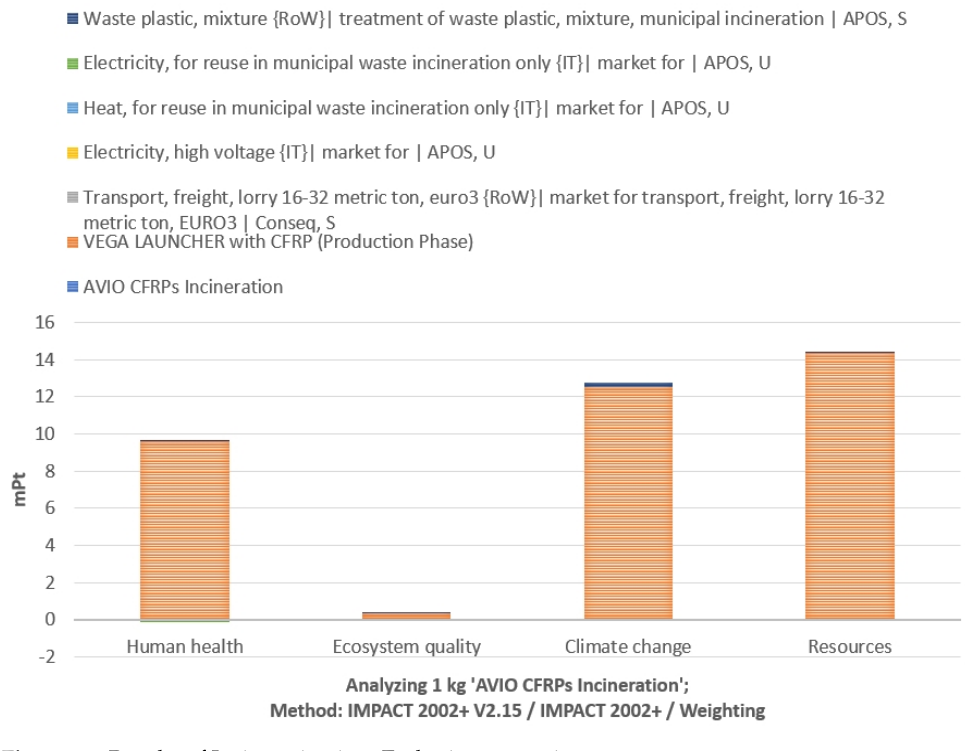
Figure 12. Results of Incineration into Endpoint categories.